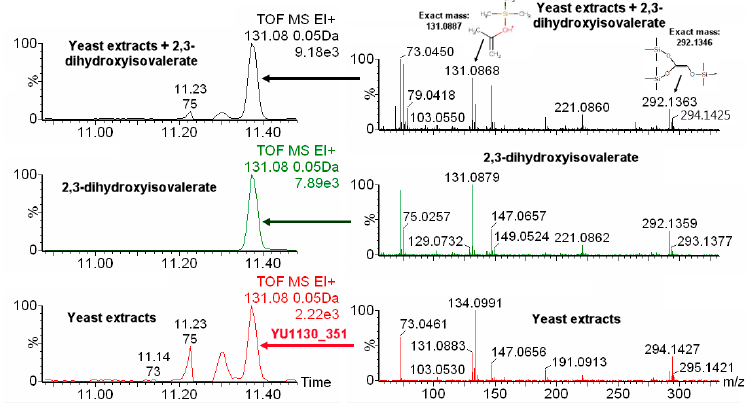
Figure 4. Extracted ion chromatogram (EIC) of m/z 131.08 and mass spectrum of silylated yeast extracts, 2,3-dihydroxyisovalerate, and their combination. Bottom panels (in red color) are the EIC and the mass spectrum from yeast extracts, the middle panels (in green) are the EIC and the mass spectrum from the pure compound (2,3-dihydroxyisovalerate) after derivatization, and top panels (in black) are the EIC and the mass spectrum from yeast extract spiked with pure compound (2,3-dihydroxyisovalerate). The parent molecule has five carbons, and the fragments m/z of 131.0887 and 292.1346 have three carbons and two carbons, respectively, in addition to the silylation group carbons (top right panel). The IROA fragment peak pairs, 131/134 and 292/294, are clearly seen, but their ratio is different between the bottom and top panels due to spiking with the unlabeled